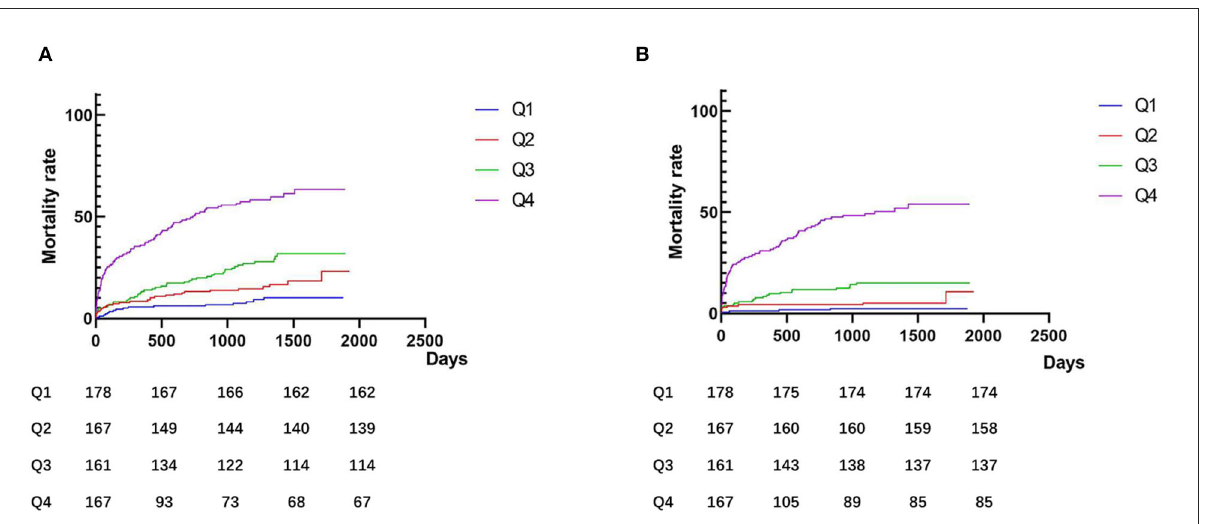
0.457–0.956, p = 0.028], and CCB [HR: 1.484, 95% CI: